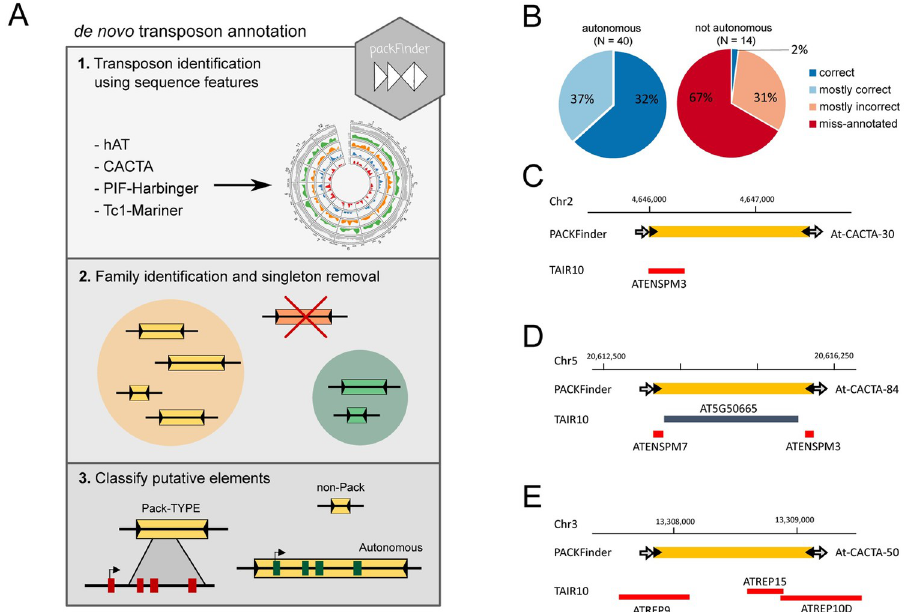
Fig 1. The packFinder automatic annotation pipeline identifies Pack-CACTA TEs in Arabidopsis. A The